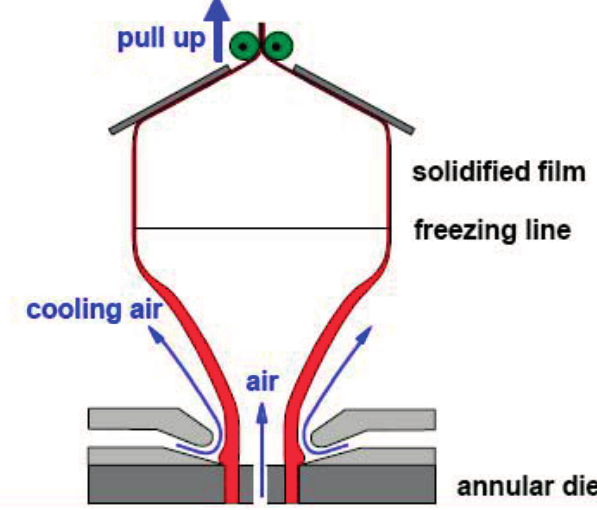
Figure 1. Schematic diagram of the film blowing experimental